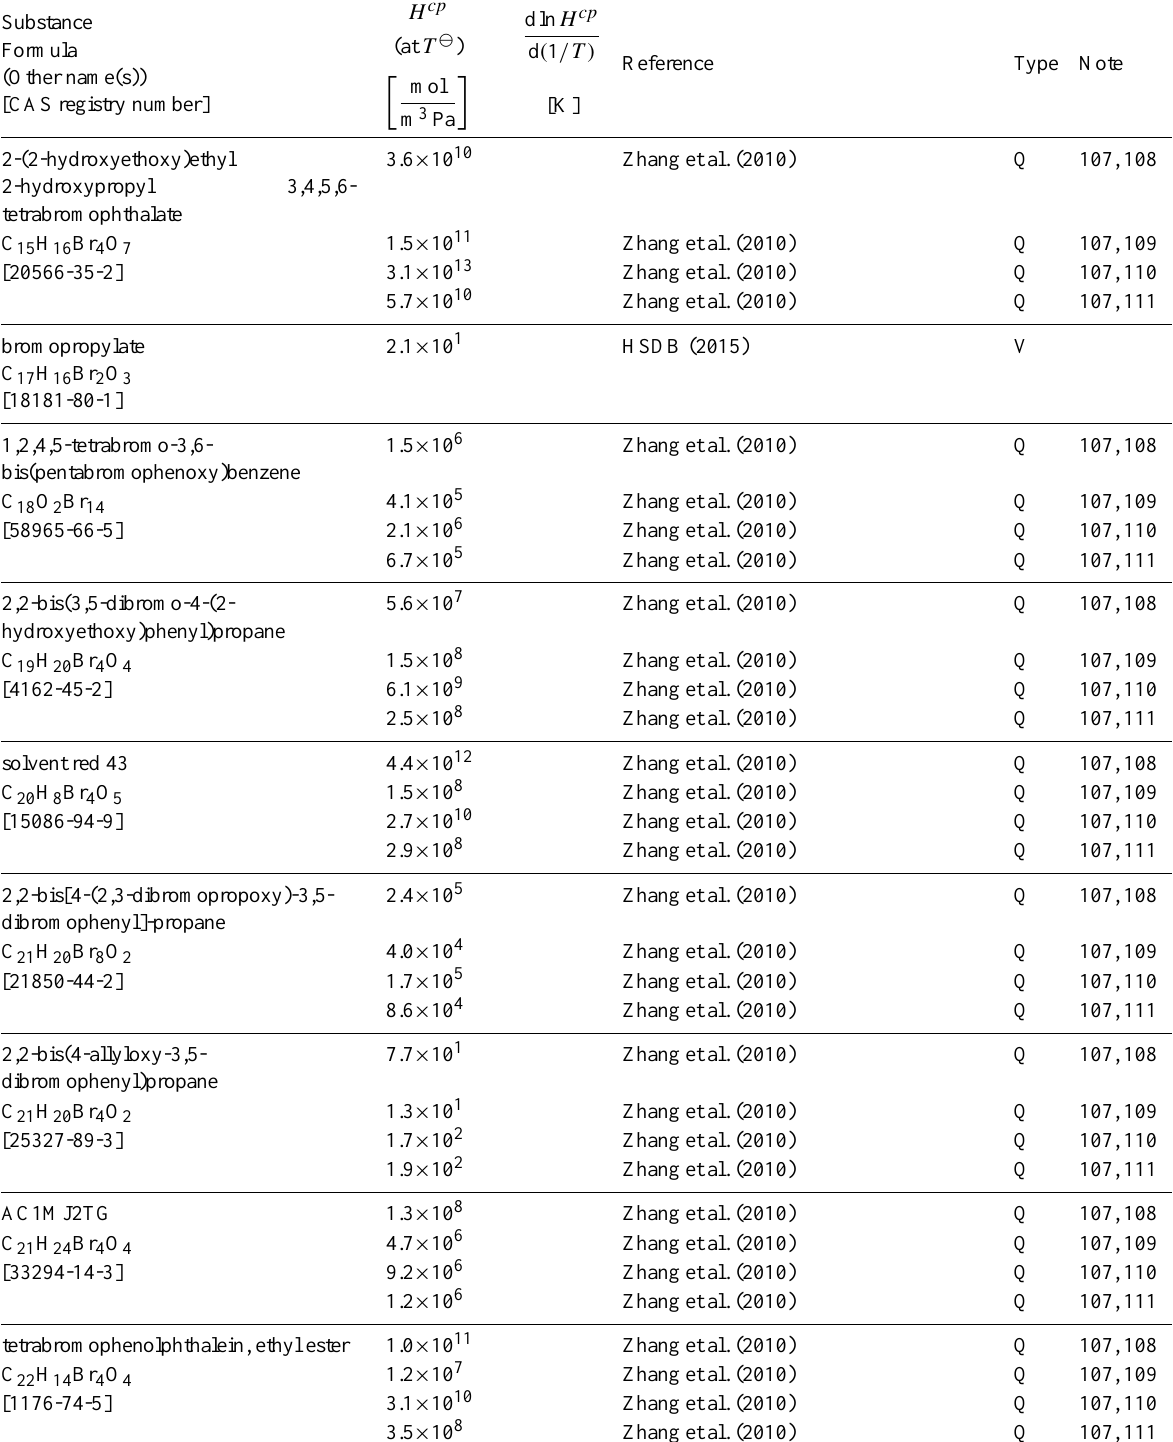
Table 6: Henry’s law constants for water as solvent